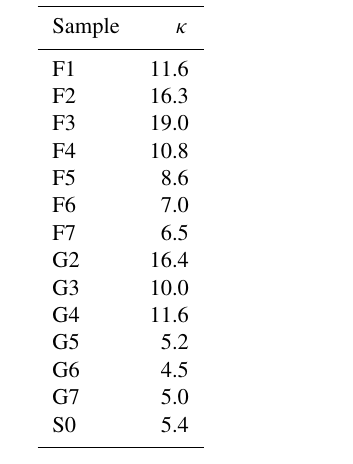
Table 3. Estimates of κ according to Eq. (12) for the samples with artificial ferrihydrite and goethite coatings (Set A).